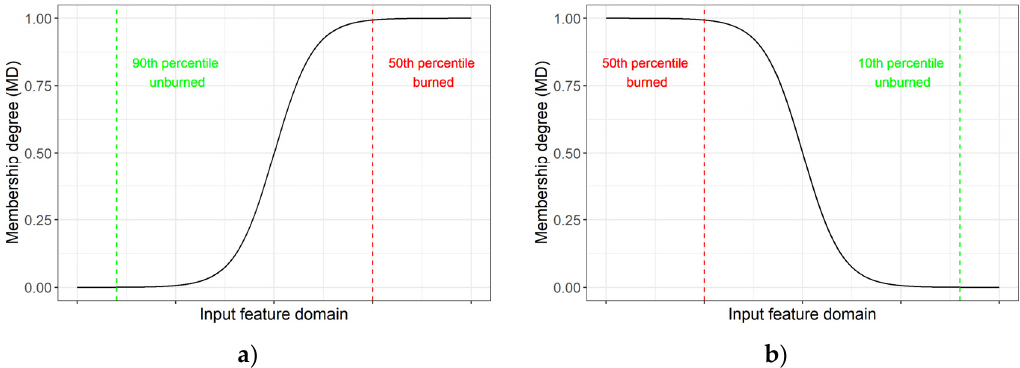
Figure 4. The s-shaped ( a ) and z-shaped ( b ) sigmoid functions chosen as MFs to quantify the partial evidence of burn.